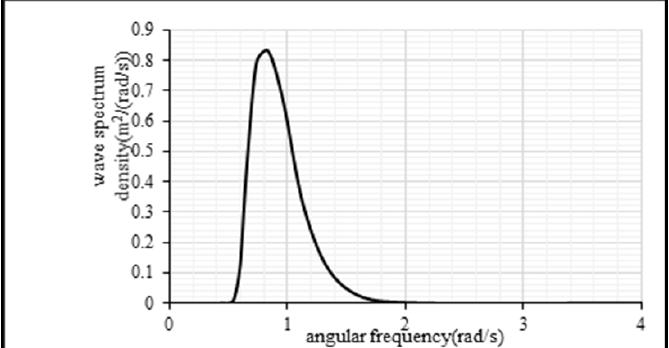
Figure 4. Wave spectrum of the South China Sea.